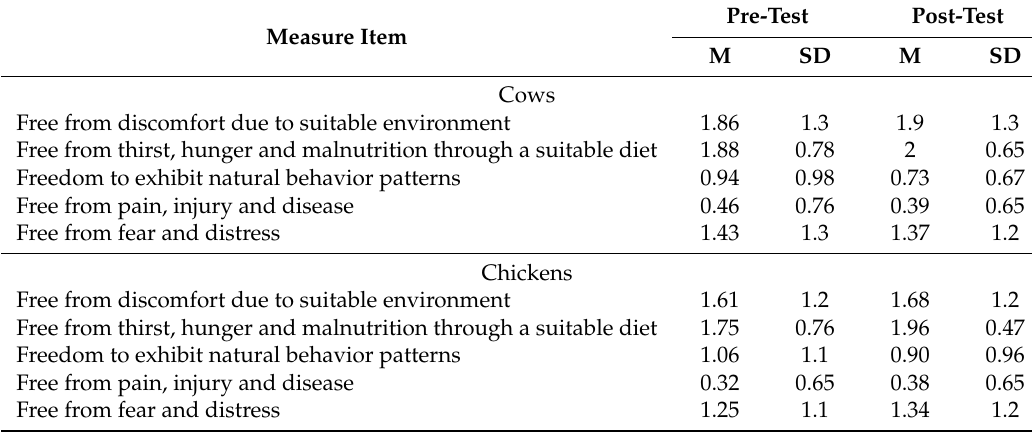
Table 7. Descriptive statistics for knowledge about the five freedoms for animals, displaying mean scores for each item for the intervention group.